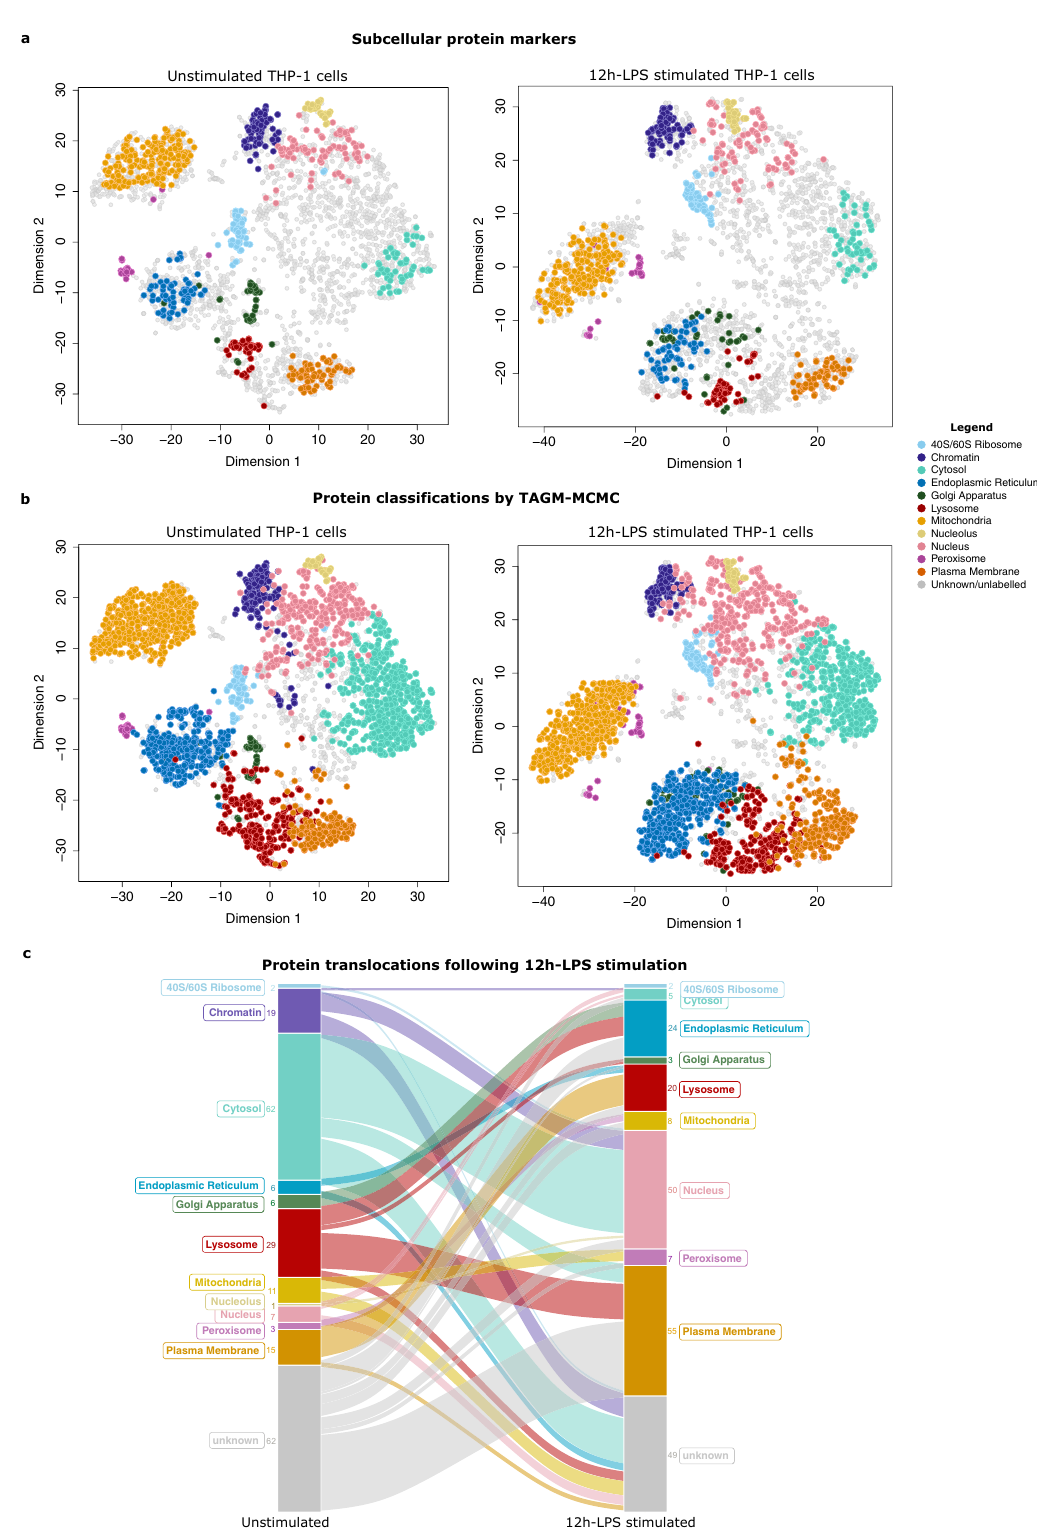
Fig. 4 Assignment of proteins to subcellular organelles using TAGM-MCMC semi-supervised classi fi er for spatial proteomics data. a Shown are the t-SNE projections of the unstimulated (0 h-LPS) and stimulated (12 h-LPS) hyperLOPIT datasets. 3288 proteins are shown in each plot and coloured by organelle protein marker classes. Proteins of unknown/unlabelled locations are shown in grey. b Shown is the same t-SNE projections following TAGM- MCMC classi fi cation. c An alluvial plot representing the 253 proteins that are found to move between organelles at 12 h-LPS. The number of proteins that are found to translocate to and from each subcellular compartment is denoted next to the labelled strata. The colours of organelles are matched to the hyperLOPIT organelle colour